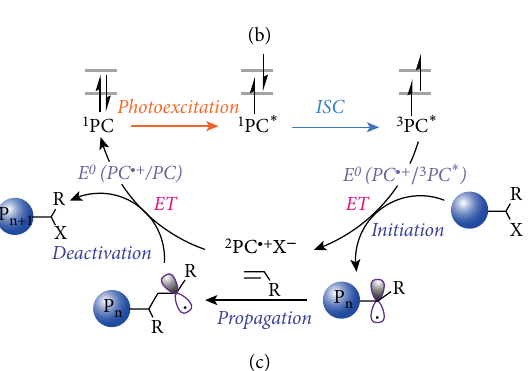
E 0 ∗ = –2.24 V E 0 ∗ = –2.06 V